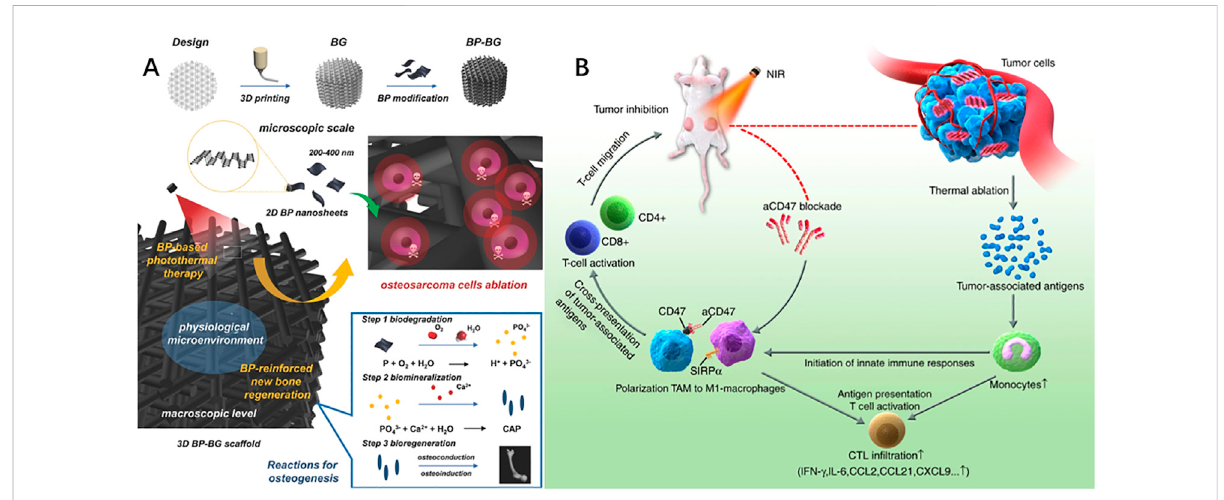
FIGURE 4 (A) 2D-Black-Phosphorus-Reinforced 3D-Printed Scaffolds. Schematic illustration of the fabrication process for BP-BG scaffold and the stepwise therapeutic strategy for the elimination of osteosarcoma followed by osteogenesis by BP-BG. (B) Black phosphorus-based photothermal therapy with aCD47-mediated immunotherapy. Black phosphorus in combination with anti-CD47 antibody activates innate and adaptive immunity and promotes local and systemic anticancer immune responses, thereby providing a synergistic enhancement in inhibiting tumor progression and suppressing metastatic cancer. (A) : Yang et al. (2018). 2D-Black-Phosphorus-Reinforced 3D-Printed Scaffolds: A Stepwise Countermeasure for Osteosarcoma. Adv Mater 30(10) . doi: 10.1002/adma.201705611. (B) : Xie et al. (2020). Black phosphorus-based photothermal therapy with aCD47- mediated immune checkpoint blockade for enhanced cancer immunotherapy. Light Sci App l 9, 161. doi: